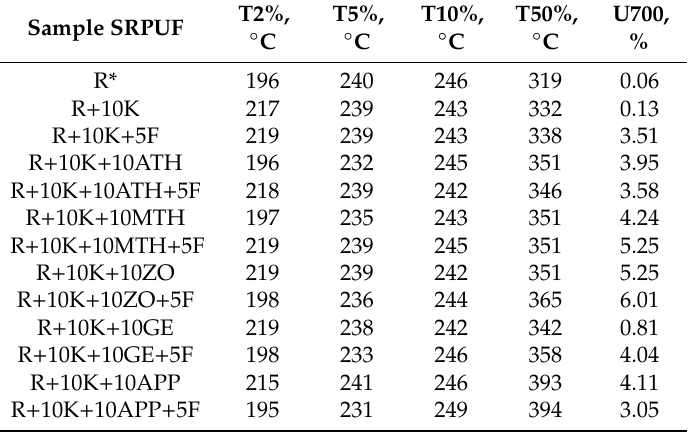
Table 5. Results of TG curves analysis obtained by TGA measurements carried out in air